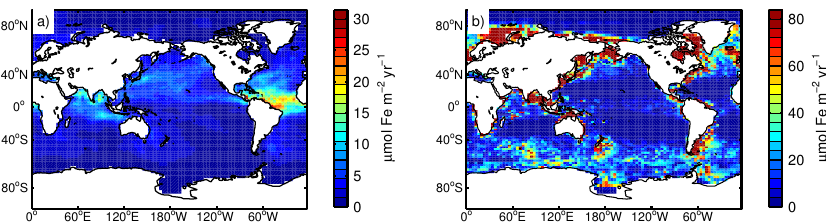
Figure 2. Annually averaged atmospheric deposition and sediment release of iron. (a) A preindustrial estimate of climatological annually averaged dust deposition (Luo et al., 2008). (b) Sedimentary iron release as simulated with the model according to Eqs. (25) and (26). Note the different color